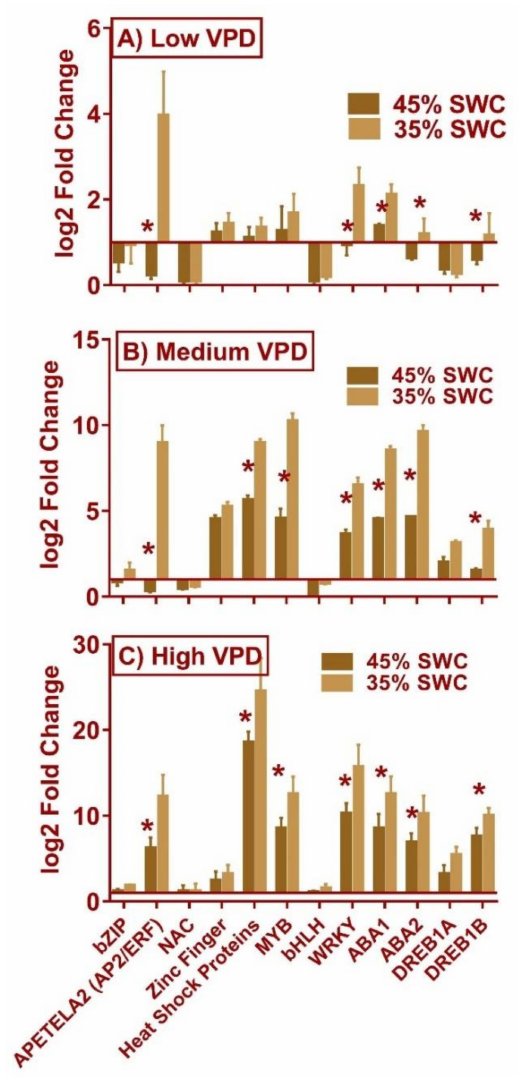
Figure 5. The relative gene expression of 12 different drought responsive transcripts measured in maize subjected to three soil water levels (well-watered, 45% soil water content (SWC), and 35% SWC) at three different vapor pressure deficit (VPD, kPa) conditions. The relative expression of 45% SWC and 35% SWC at each VPD level was calculated based on the expression in well-watered conditions. Bars (Average ± S.E.) represented with * were significantly different for 45% and 35% based on Tukey’s kramer method at each VPD